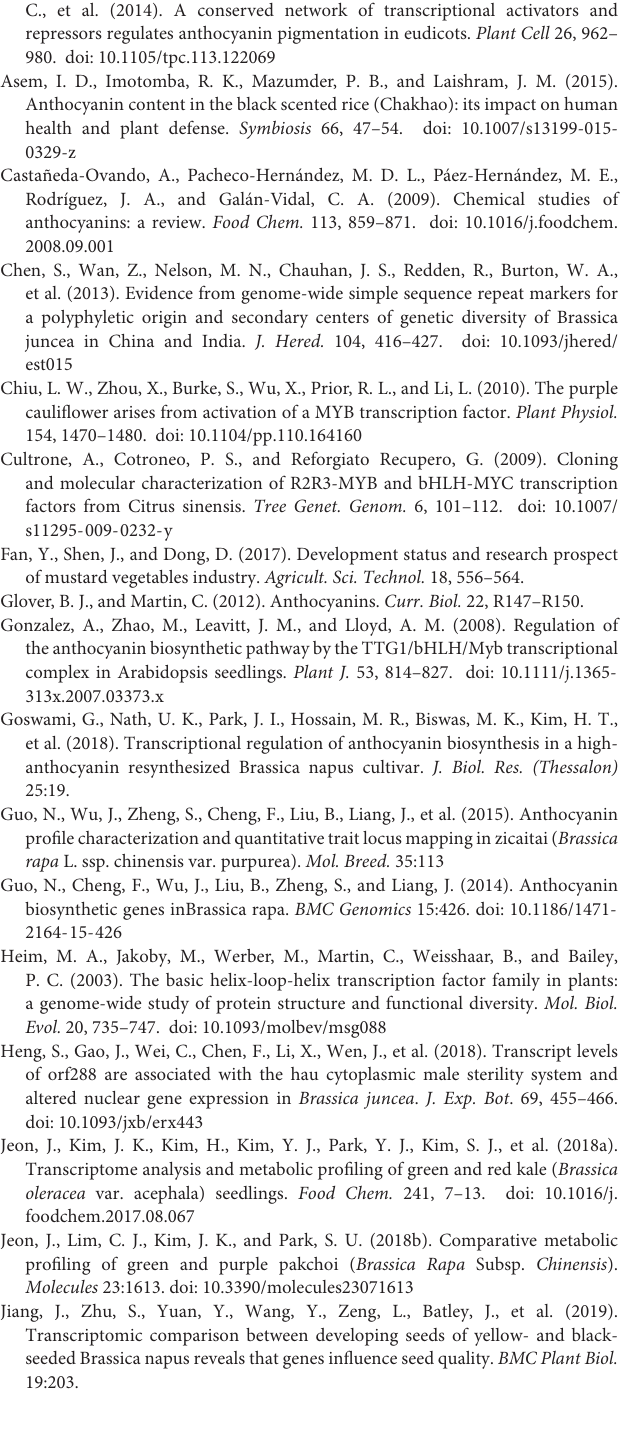
TABLE S2 | Genetic analyses of the purple leaves in F2 and backcrossed segregating populations. TABLE S3 | Detail of DEGs identified between the purple leaves and green leaves.